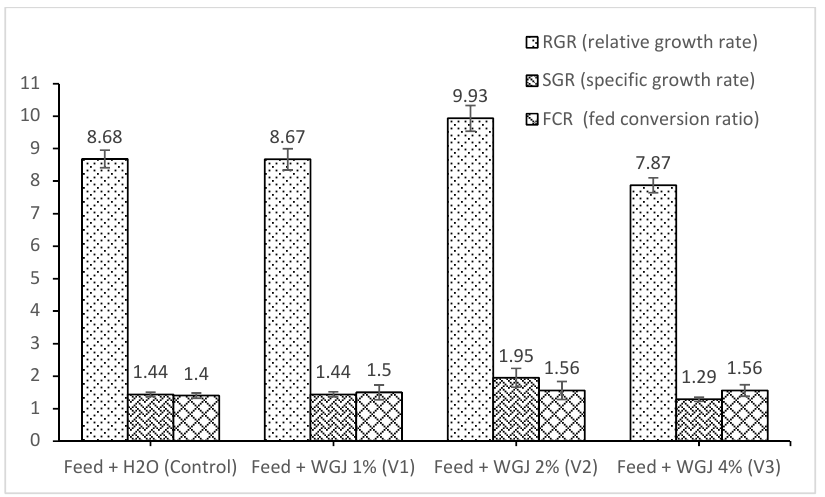
Figure 2. Performance of common carp feed four diets with different inclusion levels of wheat grass juice (WGJ): RGR—relative growth rate, SGR—specific growth rate, and FCR—feed conversion ratio. Results are means ± standard error.